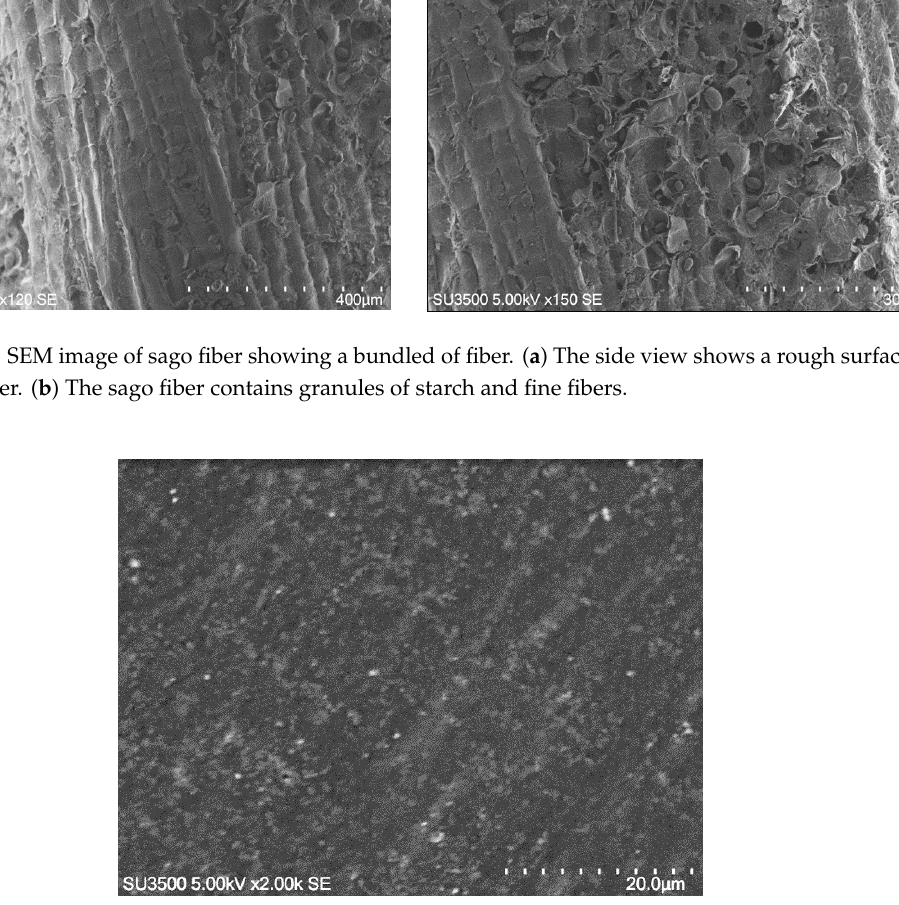
Figure 3. SEM image of epoxy resin showing small air bubbles and patterned lines.